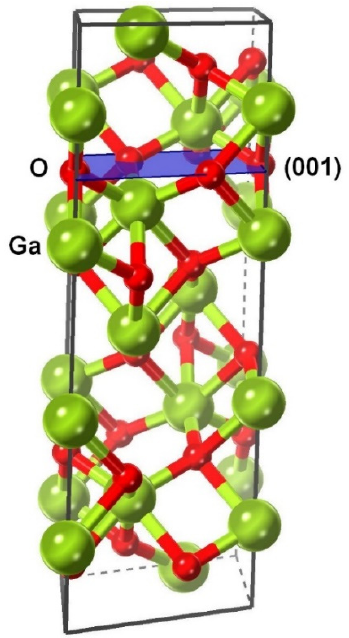
Figure 14. Configuration of atoms in 𝛼 -Ga 2 O 3 of the corundum structure. The <001> axis is directed upwards. Large green balls represent Ga atoms; small red balls represent O atoms. upwards. Large green balls represent Ga atoms; small red balls represent O